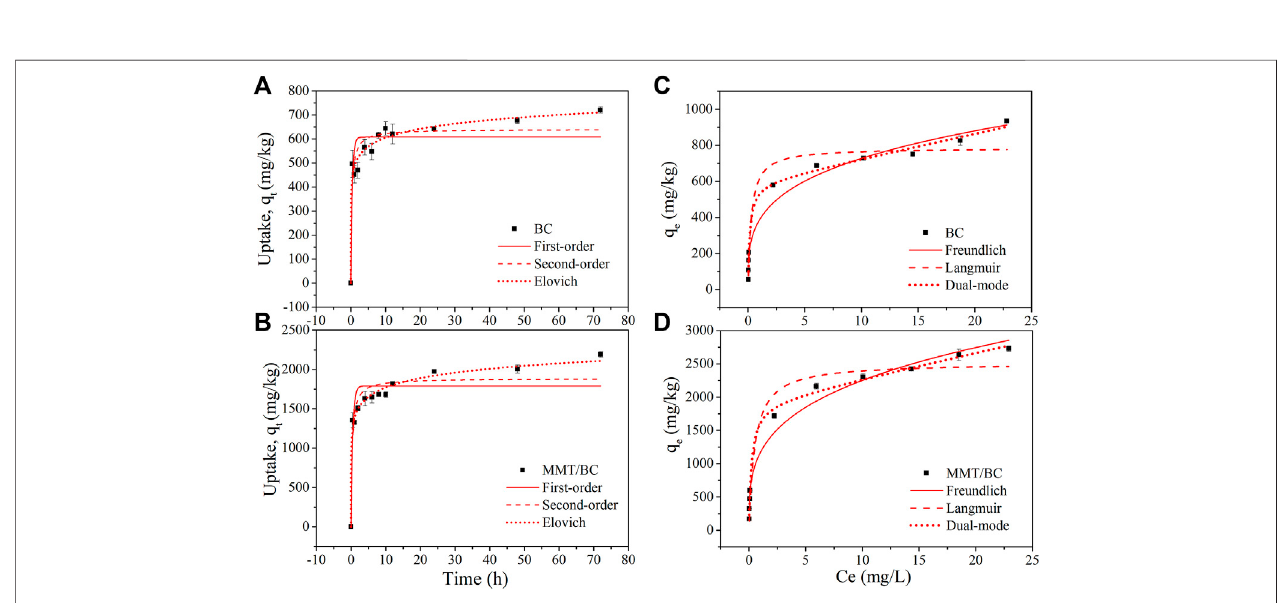
FIGURE5 | Sorption kinetics (A,B) and sorption isotherms (C,D) of atrazine on BCand MMT/BC.Kinetic data were fi ttedto fi rst-order, second-order, and Elovich models. Isotherm data were fi tted to Freundlich, Langmuir, and dual-mode models. Error bars indicate SD.